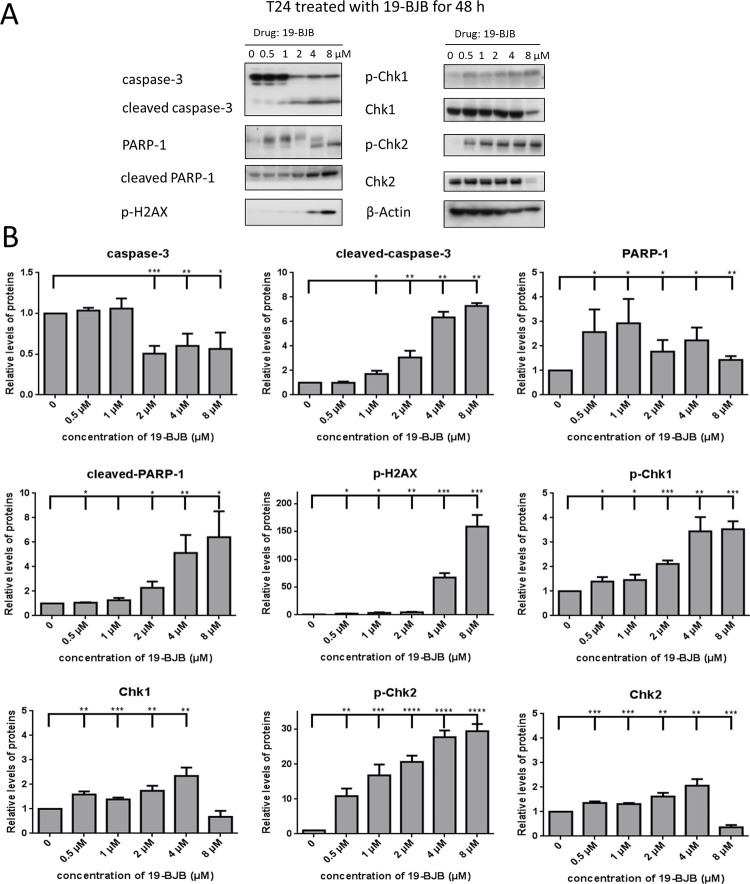
Western blots analysis of 19-BJB.T24 cells were treated with 19-BJB in varying concentration for 48 h and total cell lysates were analyzed for the expression of DNA damage repair related protein PARP-1, cleaved PARP-1, p-H2A.X, Chk1, Chk2, p-Chk1 and p-Chk2. The apoptosis related protein caspase-3 and cleaved caspase-3 were also analyzed (A). Equal protein loading was confirmed by reprobing membrane with β-actin after stripping. The relative levels of all proteins are performed (B) as means ± SD from triplicate samples for each treatment. *p < 0.05, **p < 0.01, ***p < 0.001, ****p < 0.0001.